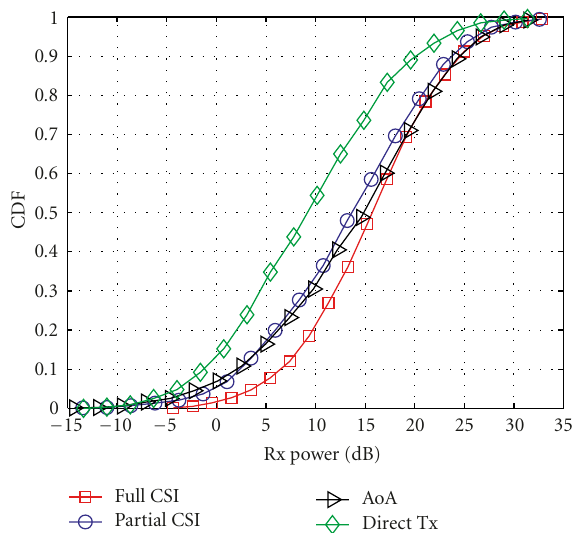
Figure 5: CDF of the received power for di ff erent transmission strategies, under fully opportunistic relay